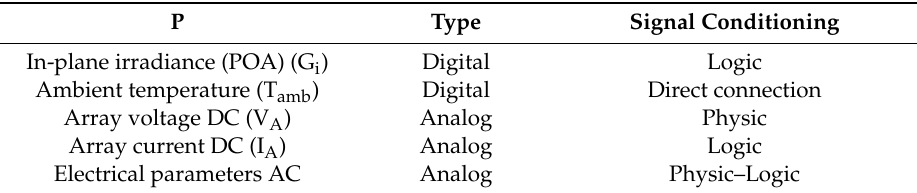
Table 2. Sensors used and classification.